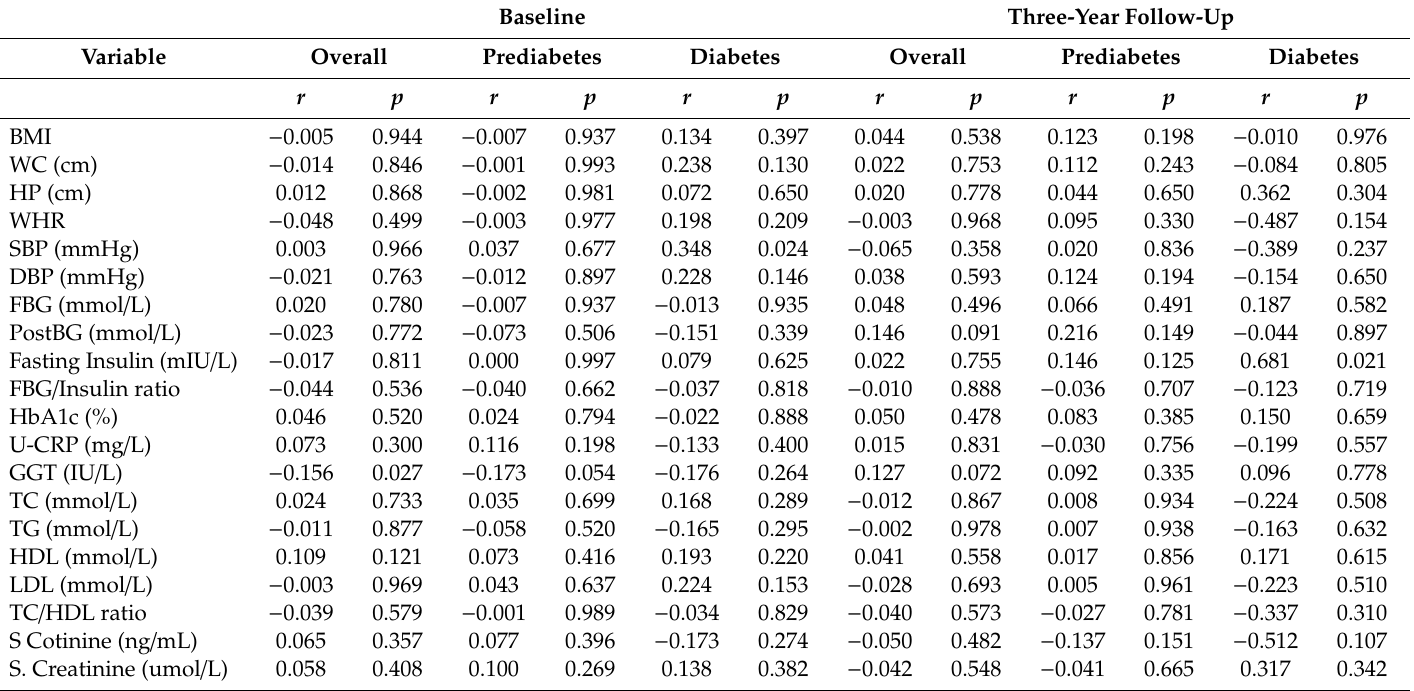
Table 3. Partial correlation coe ffi cients controlled for the e ff ects for age and gender, for the association between telomere lengths and anthropometric and biochemical parameters according to glycemic status after the baseline and the three-year